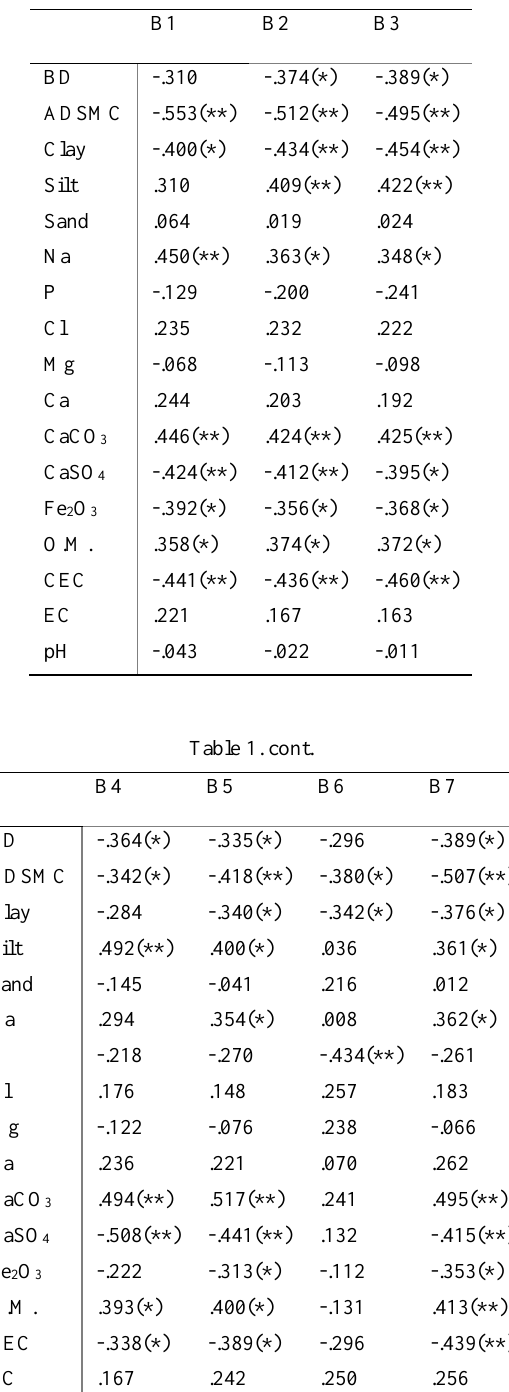
Table 1. The correlation coefficients values and significance among the surface soil properties and the Landsat ETM+